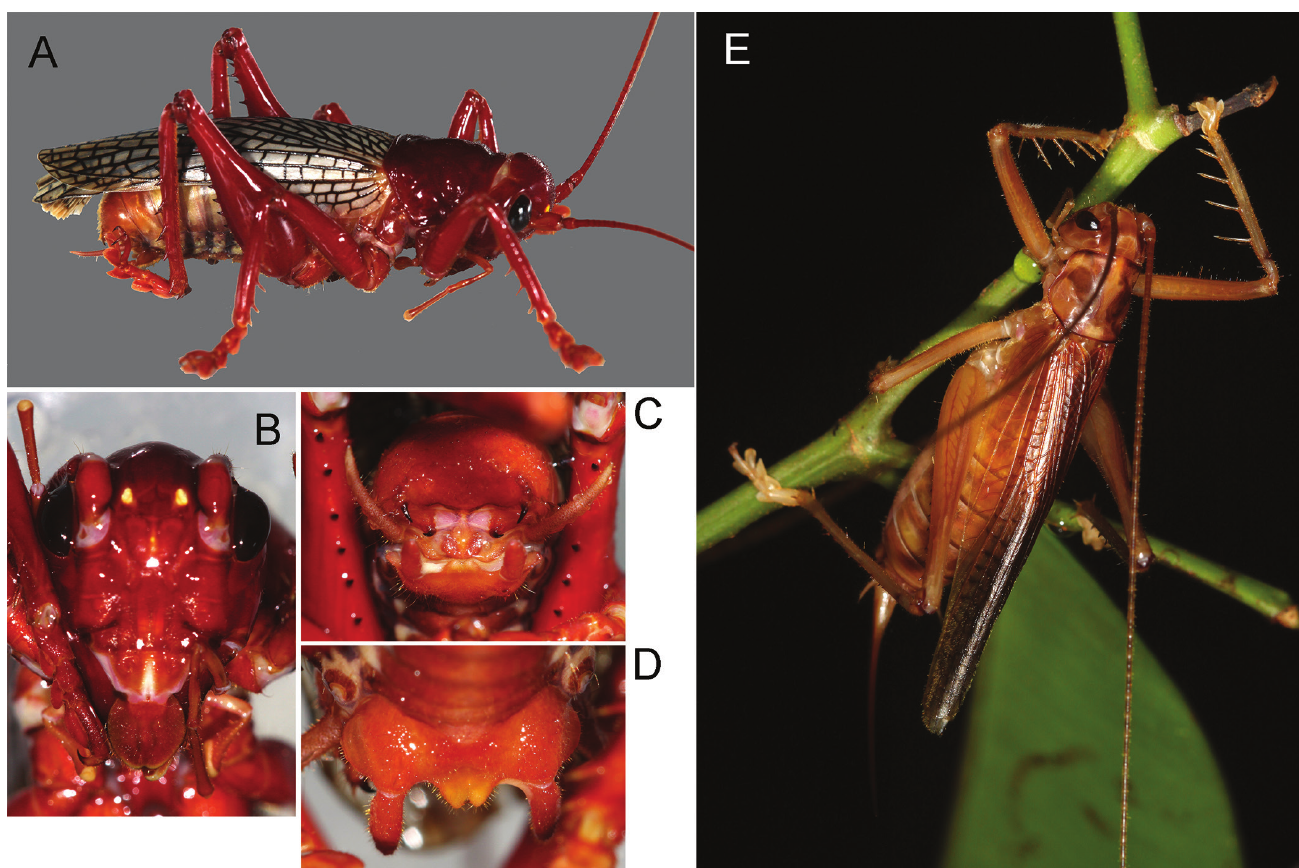
Fig. 14. Gryllacrididae: A. Phlebogryllacris (?) cf. venosa male; B. Face; C. Male abdominal apex; D. Male subgenital plate; E. Phryganog- ryllacris